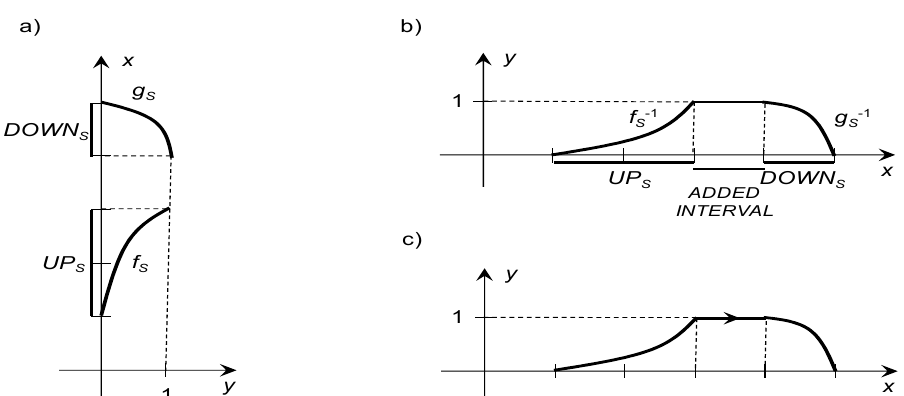
Figure 1. ( a ) Ordered fuzzy number (FN), ( b ) membership function of FN related to ordered FN, ( c ) arrow describes the positive orientation of ordered FN. Source: [20].